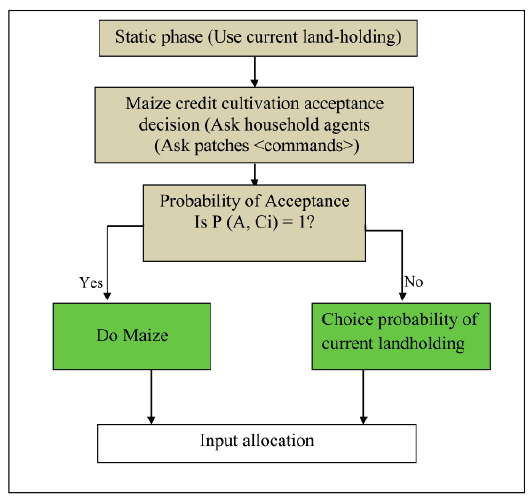
Figure 4. Maize credit adoption sub-model. Adapted from